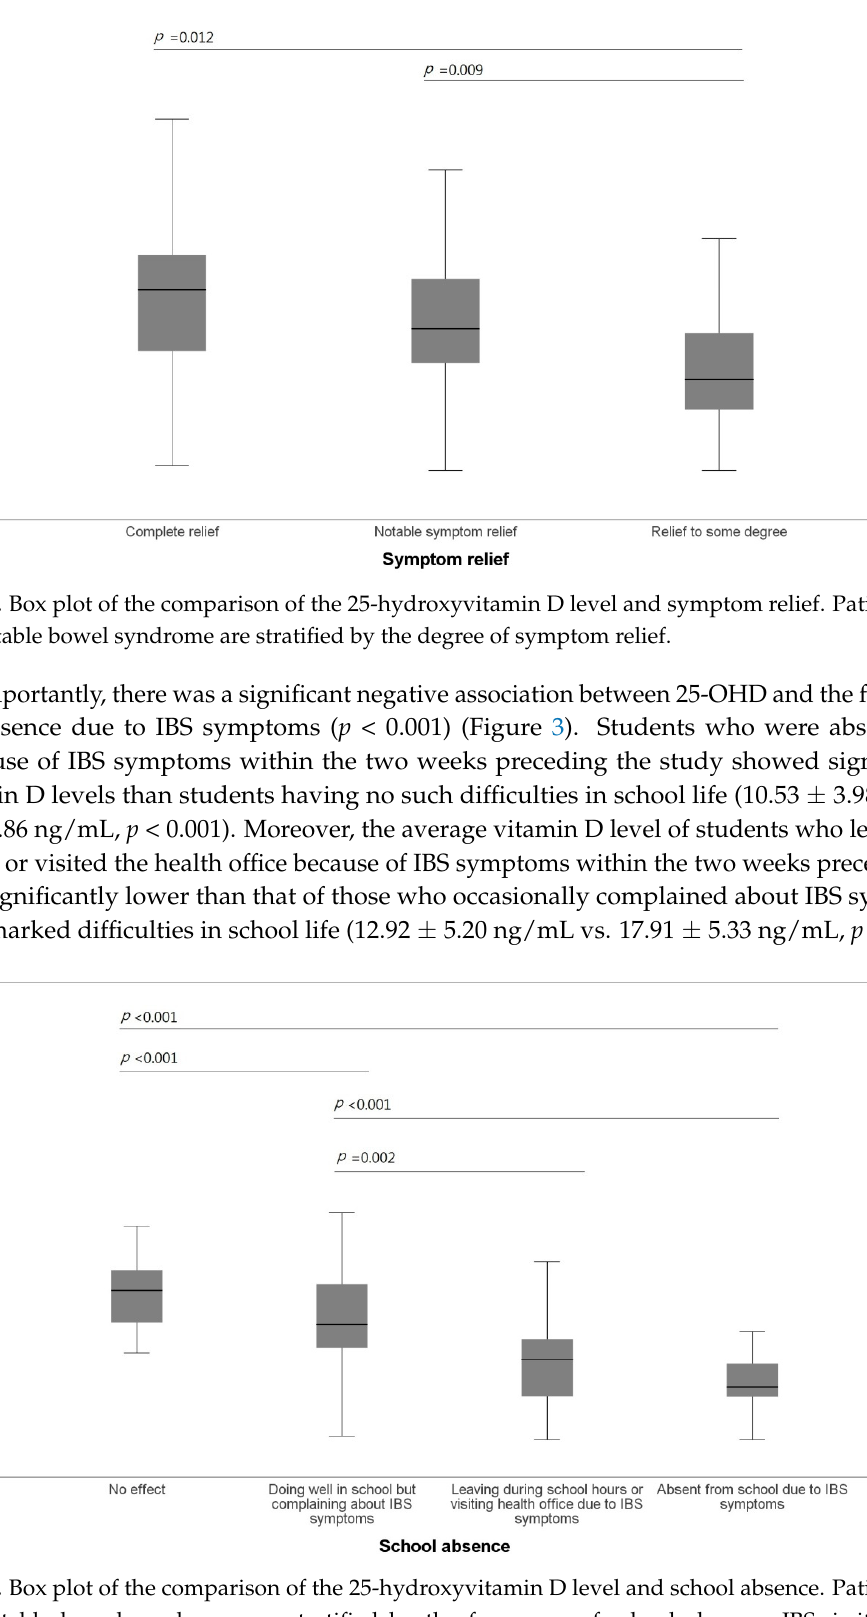
Figure 3. Box plot of the comparison of the 25-hydroxyvitamin D level and school absence. Patients with irritable bowel syndrome are stratified by the frequency of school absence. IBS, irritable bowel